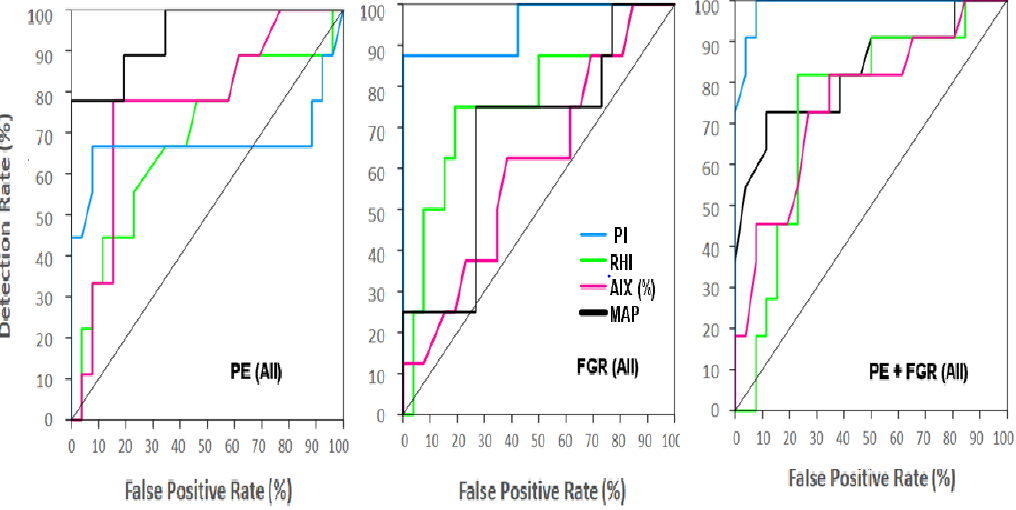
Figure 5. ROC for single biophysical markers for all patients in each complication groups. A continuous model was used to depict the ROC curves and evaluate the detection rate (DR) and the False Positive Rate (FPR). ( Left )—All cases of preeclampsia (PE), ( Middle )—All cases of Fetal Growth Restriction (FGR), ( Right )—All cases of PE + FGR. Turquoise—UtA Doppler PI, Green—MAP, Purple—AIX (%), Green—RHI, Black—MAP. The area below the line crossing from the bottom left to the upper right corner for each ROC curve represent AUC = 0.5 of a randomized accuracy.